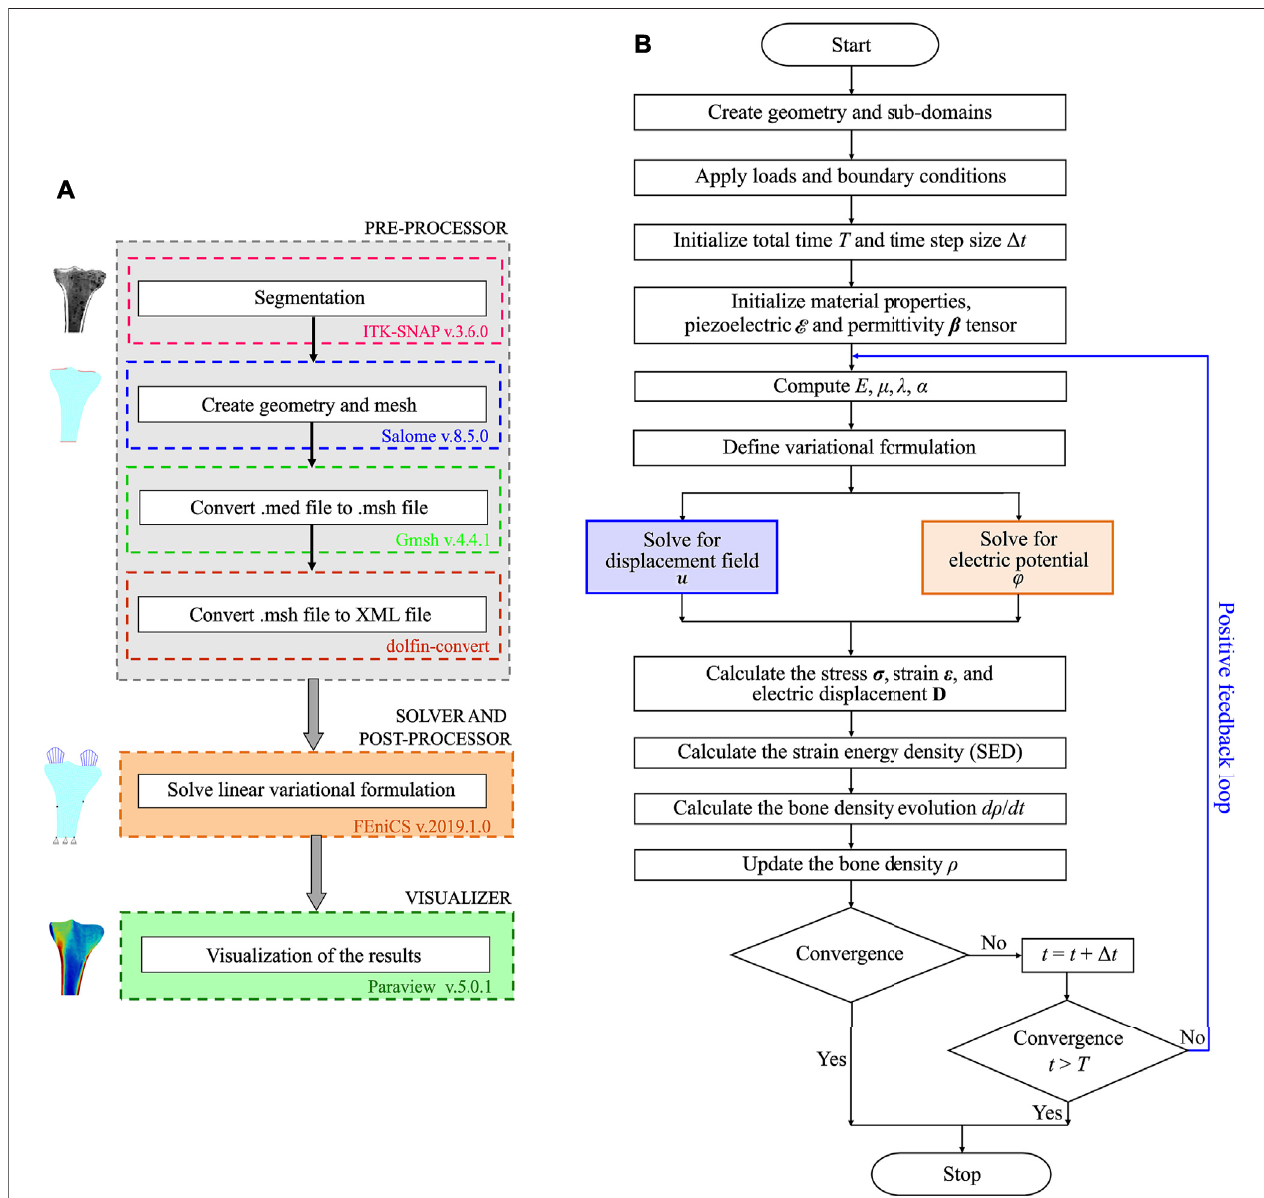
FIGURE 2 | (A) Open-source software framework used to simulate tibial bone remodeling. (B) Flowchart of the piezoelectric bone remodeling algorithm implemented in the open-source fi nite element software FEniCS.